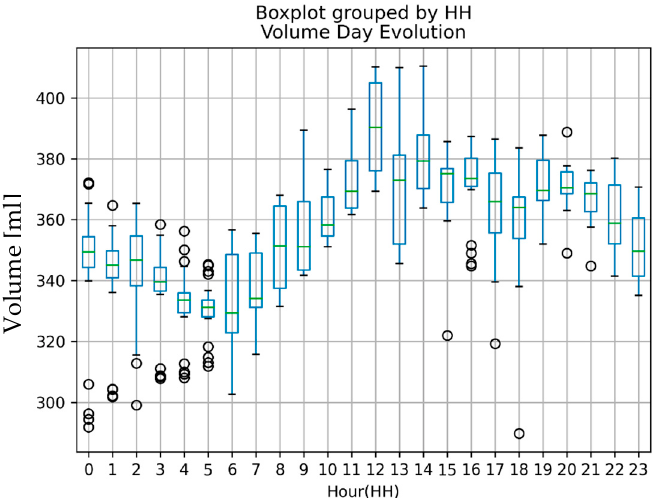
Figure 13. Medium and deviation of volume estimated, versus time along the 24 h in a day: circadian rhythm .